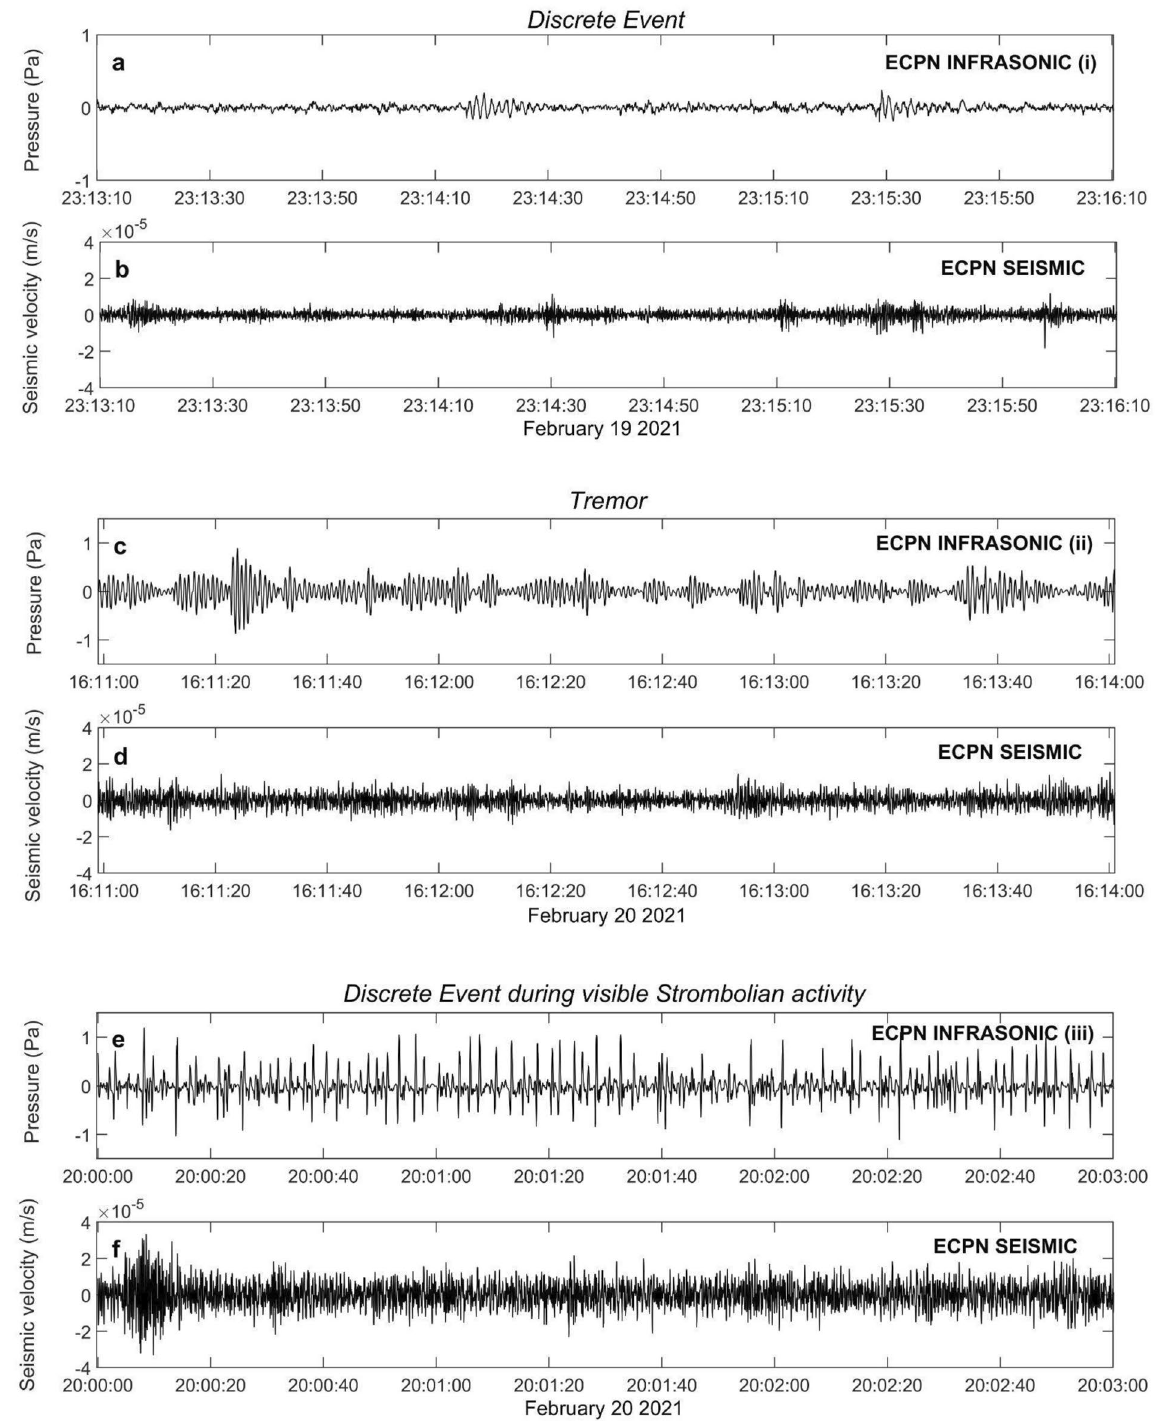
Figure 3. Three minute long infrasound and associated seismic signal examples recorded during: ( a ) and ( b ) the first phase, characterized by discrete infrasound events and no visible subaerial explosion activity; ( c ) and ( d ) the third phase featured by an infrasound event amplitude and occurrence rate increase leading to a continuous tremor; and ( e ) and ( f ) visible Strombolian activity during which discrete explosive events were recorded. The symbols (i), (ii) and (iii) in (a,c,e) are annotated at the appropriate times in Fig.